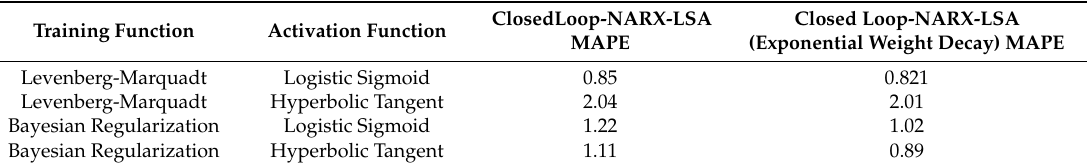
Table 3. Comparative analysis with exponential weight decay.